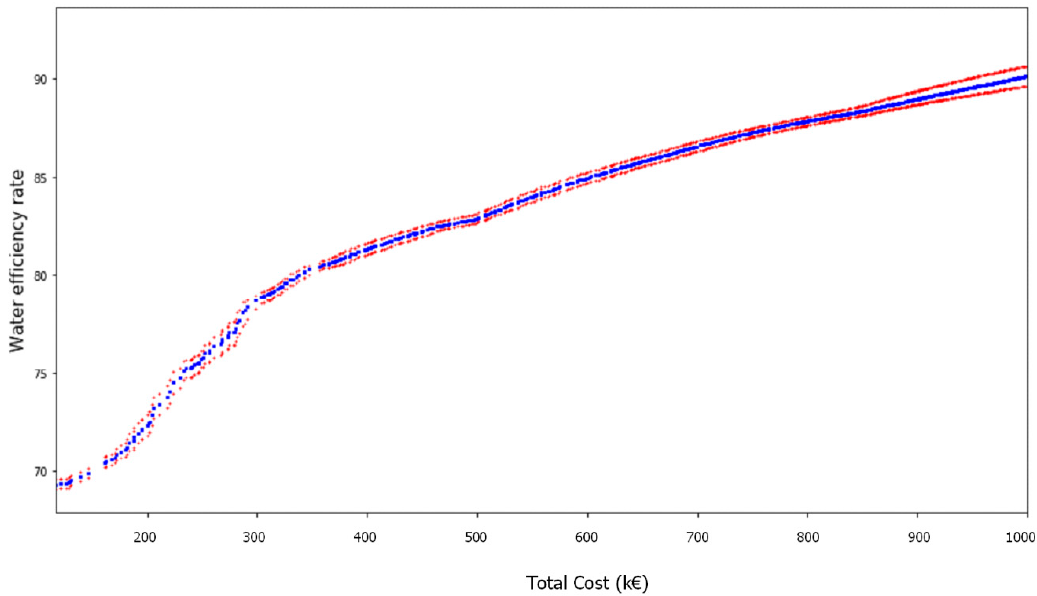
Figure 8. The Pareto front obtained from 1000 individuals and 25 generations. Table 8. Trade-off solutions with regard to considered constraints and objective.